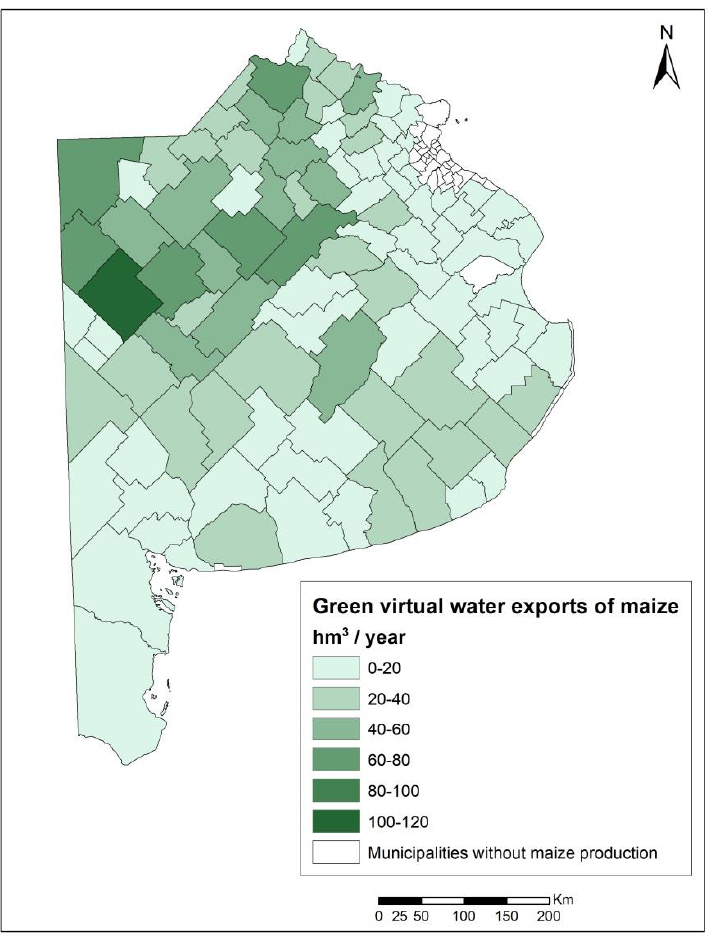
Figure 7. Green virtual water exports of maize in 2016–2017 at the municipality level in Buenos Aires province (hm 3 /year).